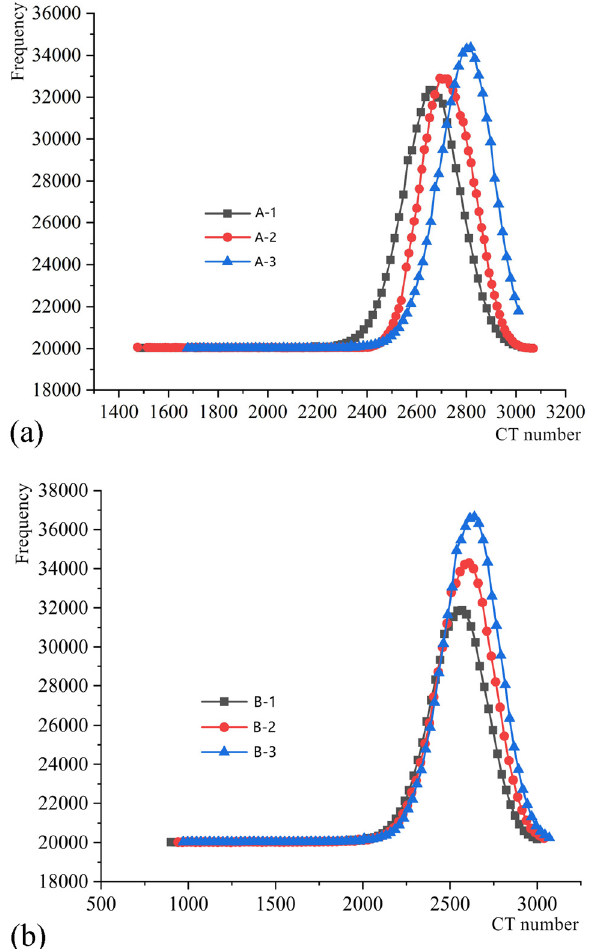
Figure 5: Microelement intensity distribution of CT numbers under di ff erent experimental conditions. ( a ) Conventional triaxial test and ( b ) triaxial compression test with step